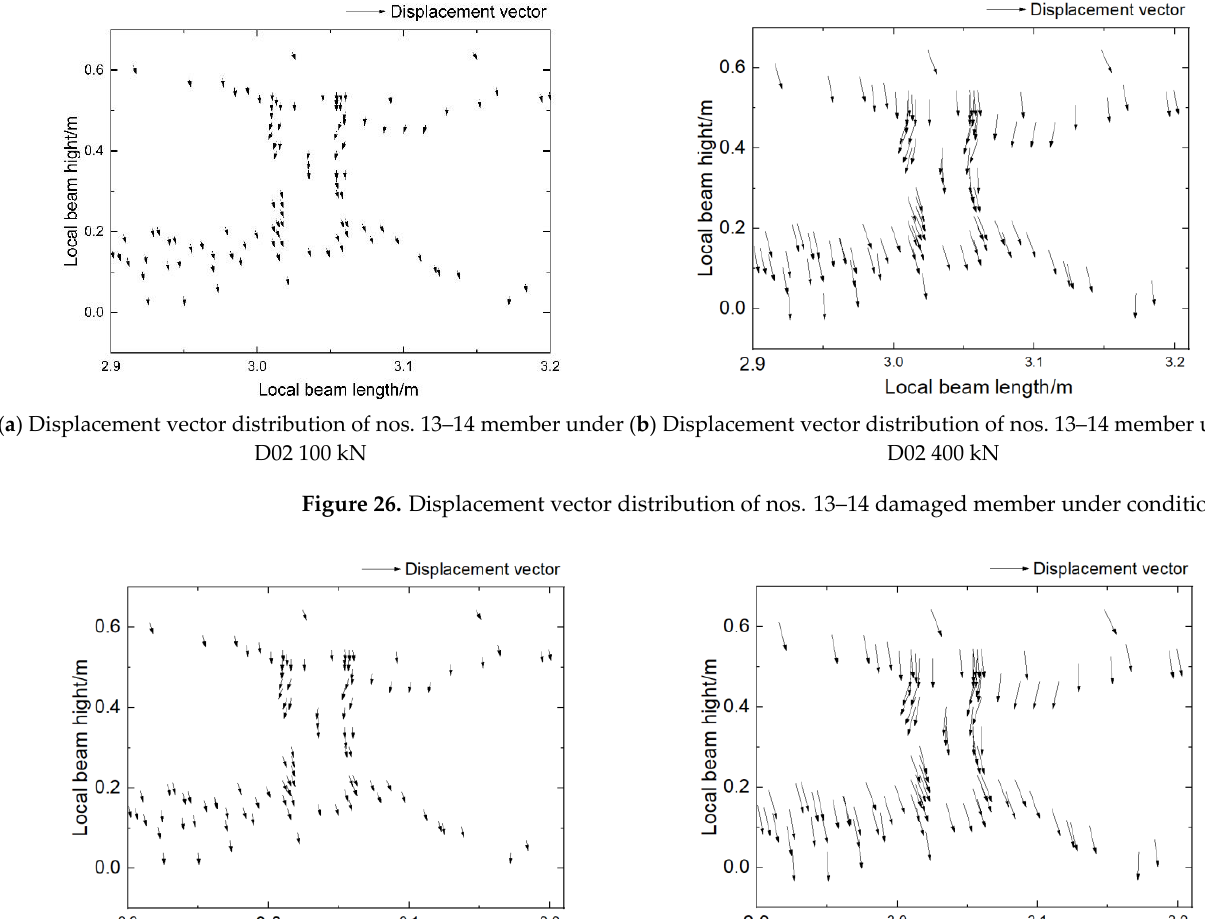
Figure 27. Displacement vector distribution of nos. 13 – 14 damaged member under condition D03.